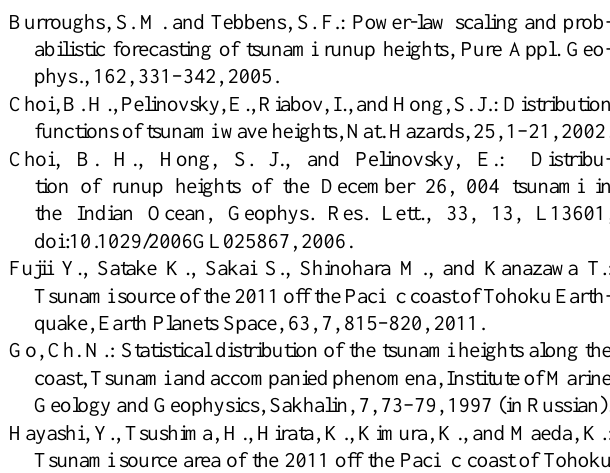
(1896, 1933, and 2011) are very well fitted by log-normal curves based on the assumption of 11